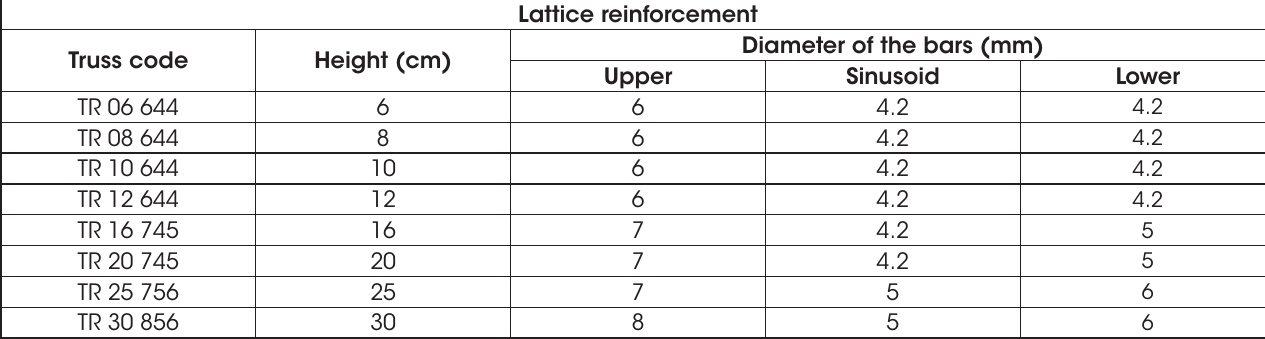
Lattice reinforcement